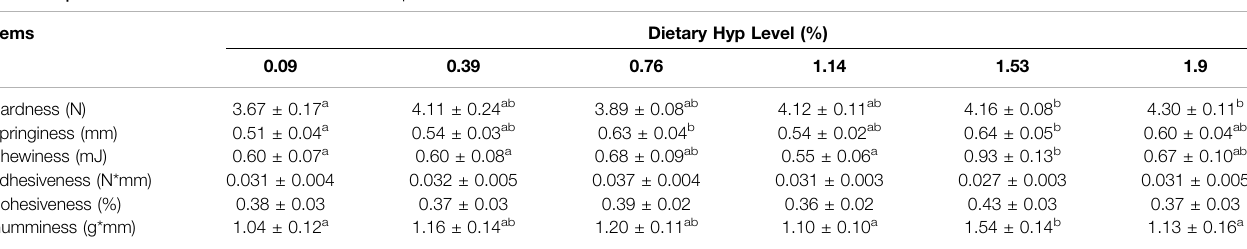
TABLE 7 | Muscle texture of ITCC fed with different experimental diets for 8 weeks.